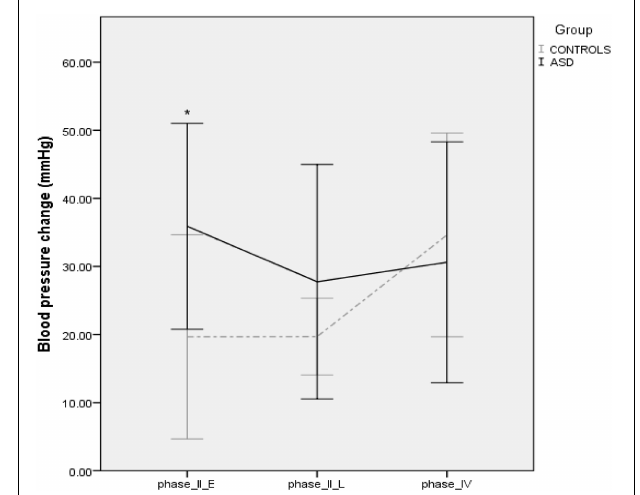
FIGURE 6 | Changes in heart rate from baseline during head-up tilt in controls and ASD. BPM, beats per minute. *Refer to a statistically significant finding.